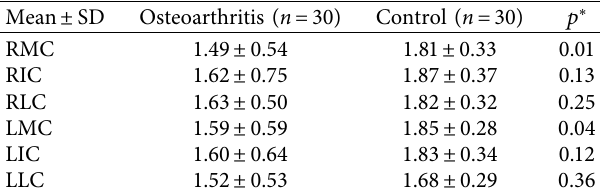
RMC: right medial condyle; RIC: right intercondylar; RLC: right lateral condyle; LMC: left medial condyle; LIC: left intercondylar; LLC: left lateral condyle. ∗ Mann–Whitney